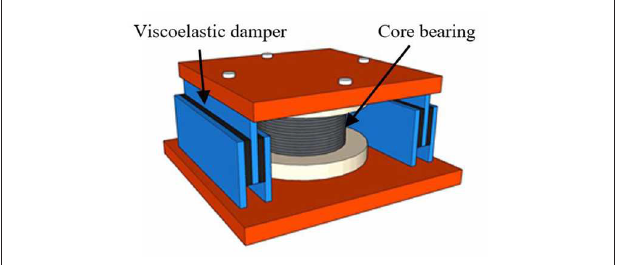
FIGURE 1 | The structural diagram of the MHEID (Xu et al., 2014).